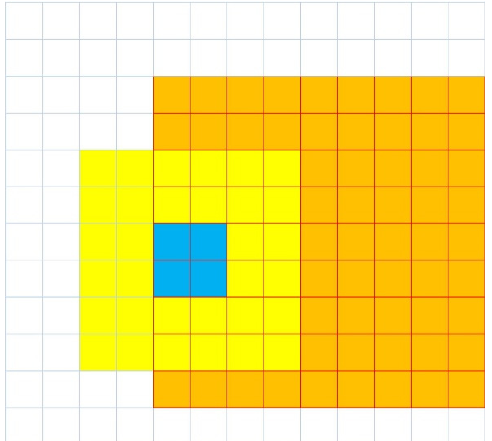
Figure 4. An example of sample selection from a slice. The sample center in the example is 2 × 2 and the sample size is 6 × 6.